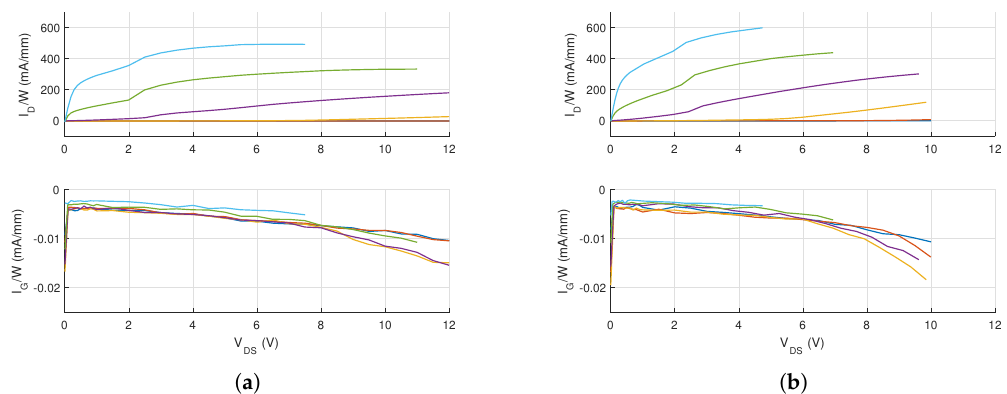
Figure 2. Normalized DC characteristics of 4x050 devices, as V GS is increased from − 2 V to − 0.75 V in 0.25 V steps: ( a ) D01GH ( b )